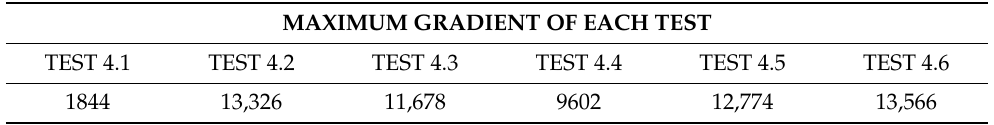
Table 3. Maximum gradient of each test in absolute value, Test